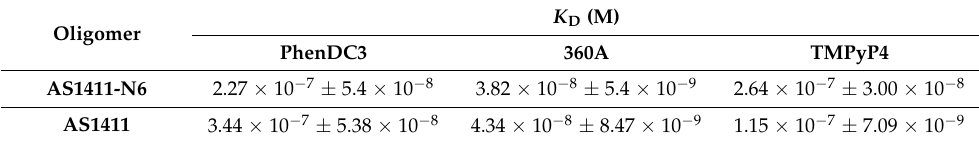
Table 3. K D constant values of AS1411-N6 and AS1411 measured by SPR